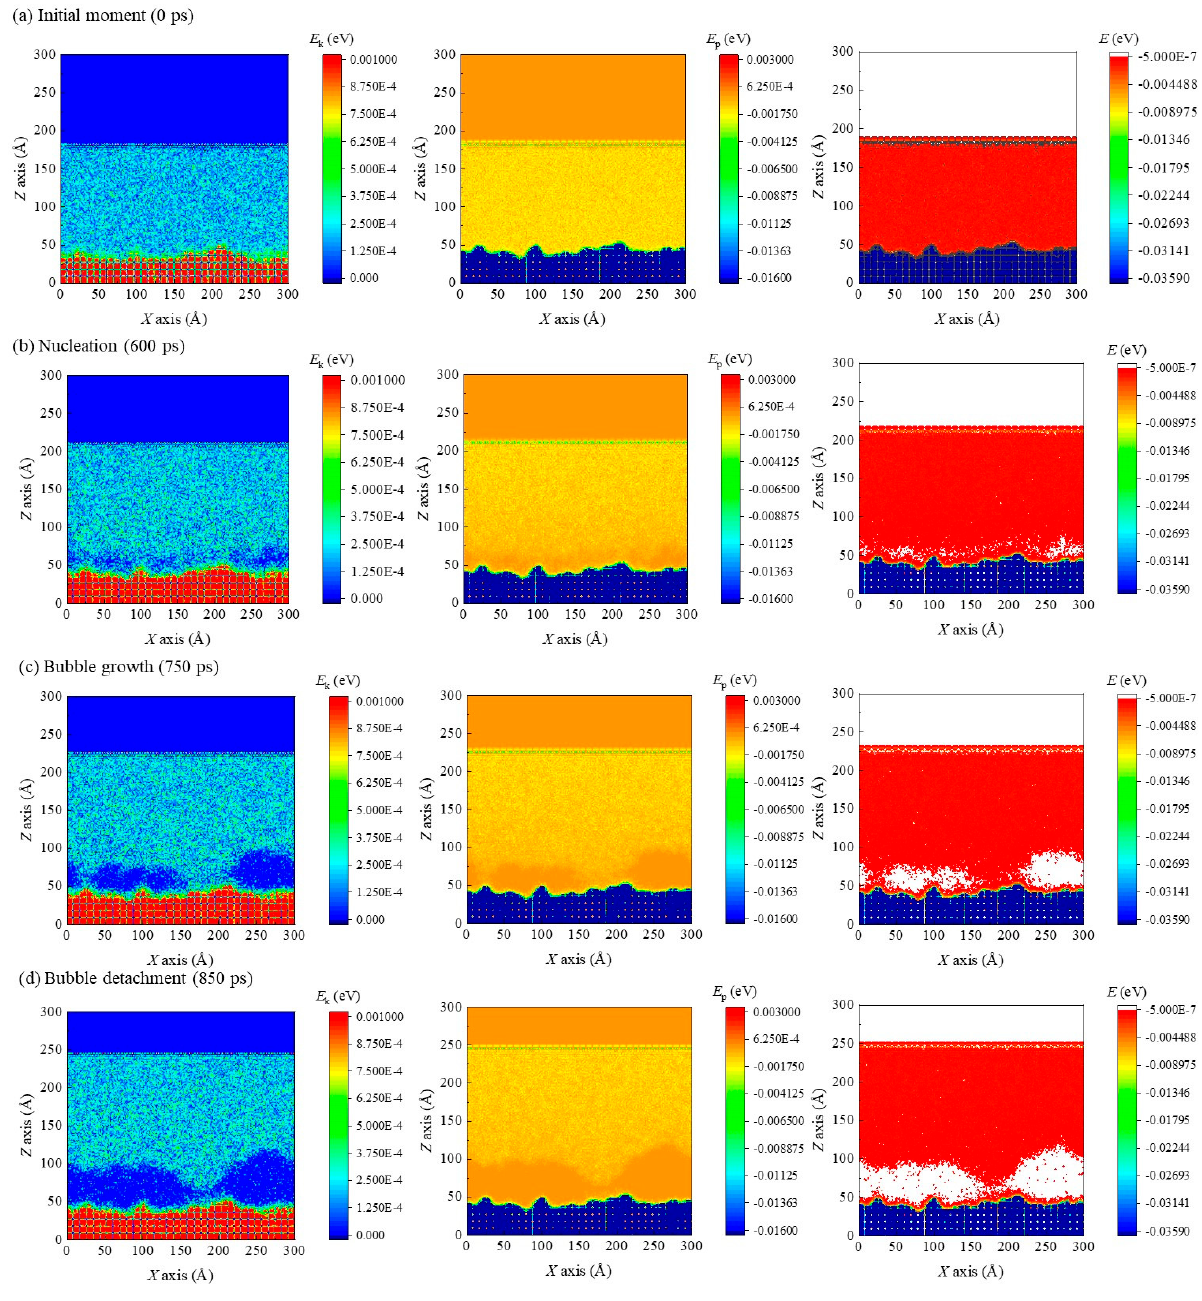
Figure 11. The kinetic energy contours (left side), the potential energy contours (middle), and the total energy contours (right side) of the case α = 1.5 at ( a ) the initial moment, ( b ) the nucleation moment, ( c ) a certain bubble growth moment, and ( d ) the bubble detachment moment.